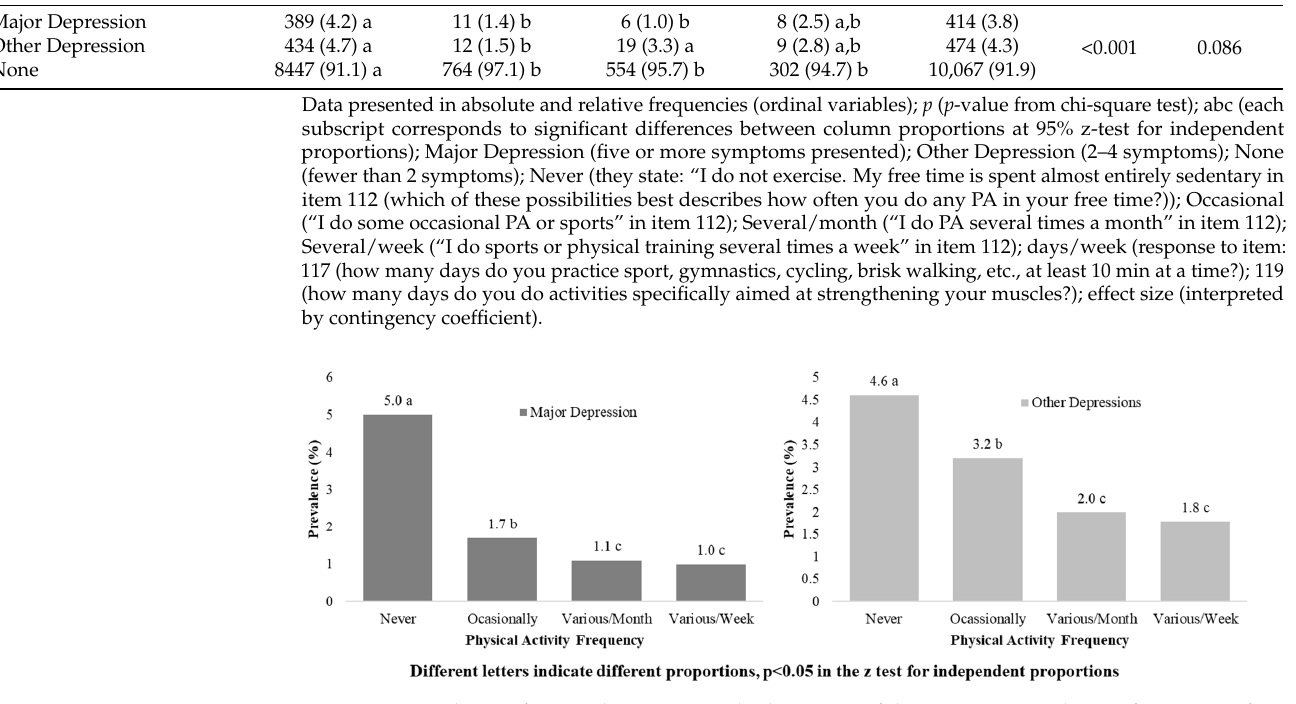
Figure 3. Prevalence of major depression and other types of depression, according to frequency of PA in the general population. Table 3. Relationship between frequency of PA, days of activity and muscle strengthening a week and depression.